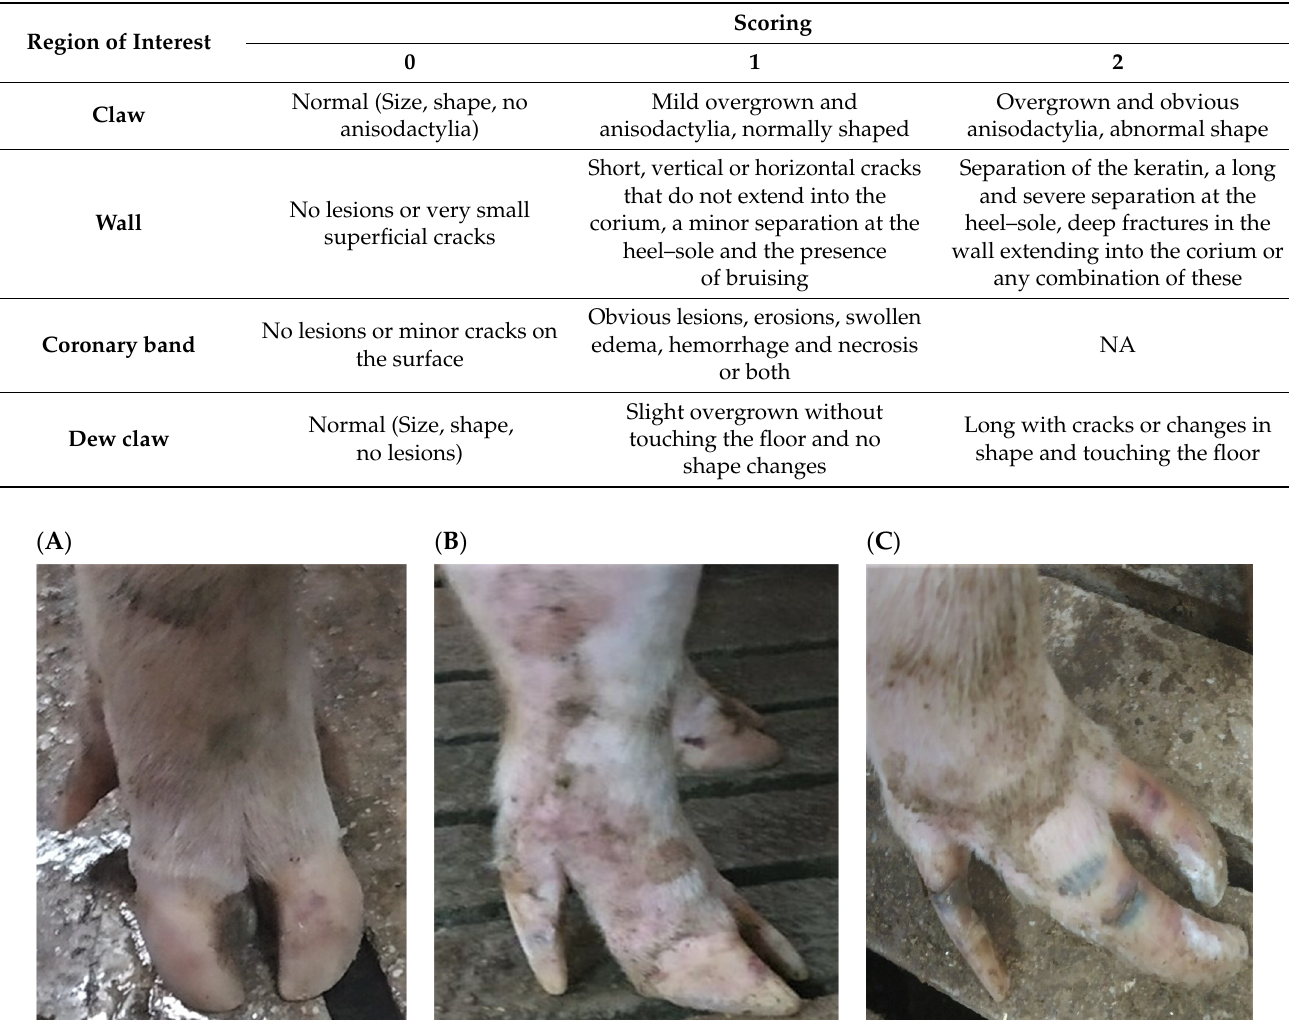
Table 1. A modified scoring system for evaluation of claw and dew claw lesions, in sows of different genetic lines in three farrow-to-finish herds in Greece.